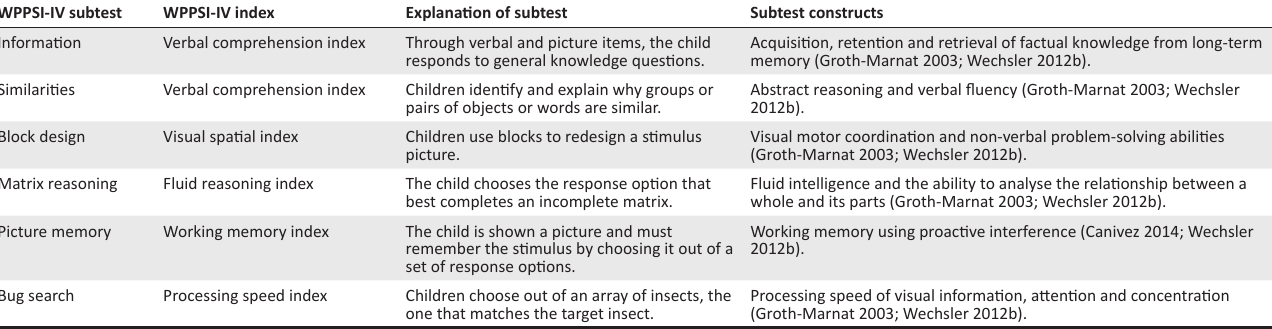
TABLE 2: Details of WPPSI-IV core